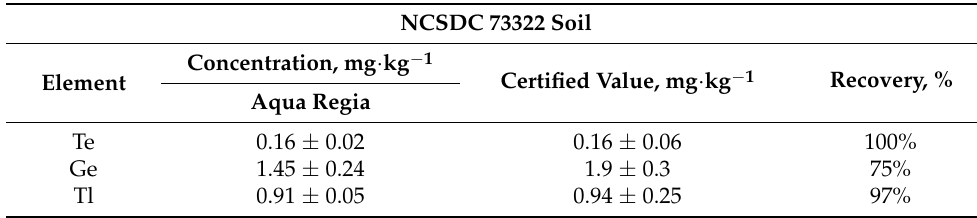
Table 4. Metal contents in soil determined by aqua regia vs recovery of a certified reference material soil (CRM) .